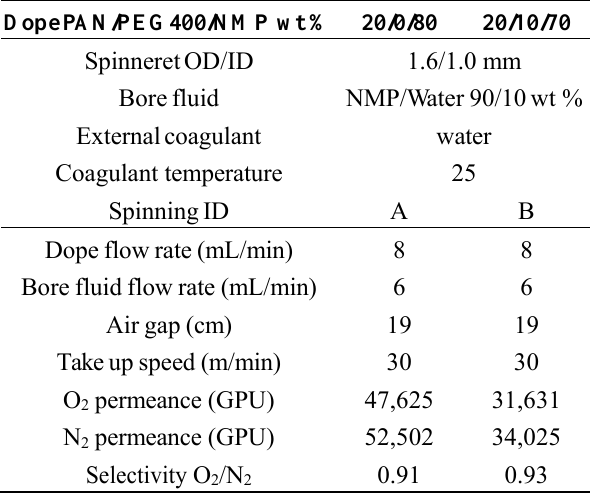
Figure 6. Cross-section morphology of PAN hollow fibers. Table 1. Spinning conditions of PAN hollow